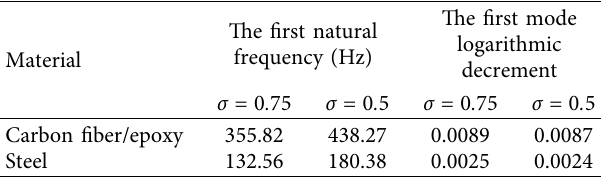
Table 3: First frequency and modal logarithmic decrement for the tapered cutter bar made of different materials. ( Ω � 0 )